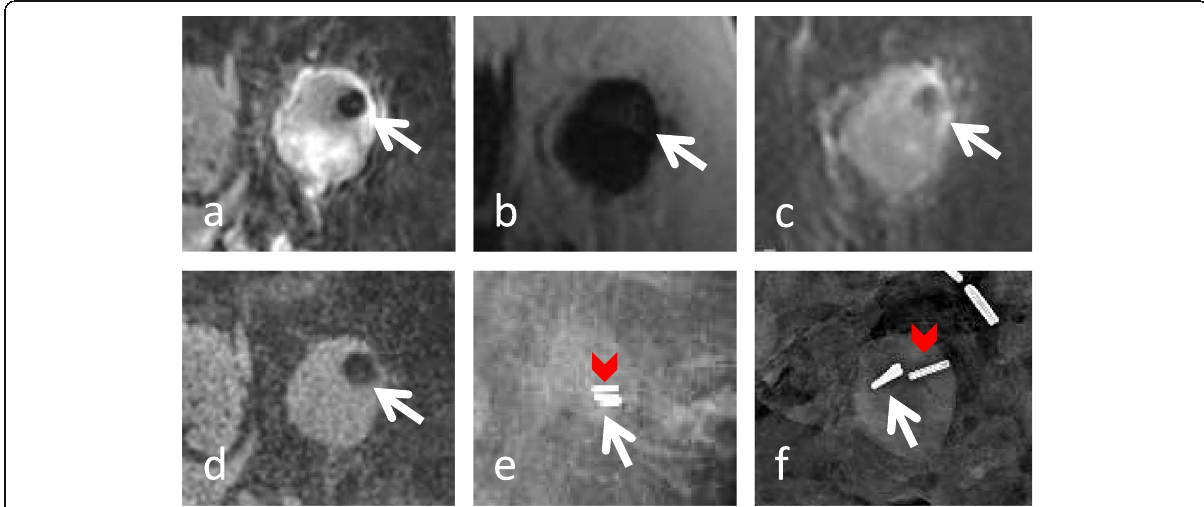
Fig. 1 A 55-year-old female with left breast multifocal invasive ductal carcinoma and biopsy proven metastatic axillary lymphadenopathy. A MammoMark® (Mammotome, Cincinnati, OH) U-shaped marker was placed after biopsy of an abnormally enlarged axillary lymph node. Initial staging magnetic resonance imaging performed 1 week after marker placement demonstrates susceptibility artifact from the marker within an abnormally enlarged lymph node on various sequences. a On the T2-weighted water-only image, the marker is dark and seen with high confidence. b On the T2-weighted fat-only image, the marker is seen with low confidence (arrow). c On the first contrast-enhanced fat- suppressed three-dimensional T1-weighted spoiled gradient-recalled image, the marker is dark (arrow) and seen with high confidence. d On the unenhanced fat-suppressed three-dimensional T1-weighted spoiled gradient-recalled image, the marker is dark (arrow) and seen with high confidence. e Post-seed localization mammogram demonstrates the marker (arrow) adjacent to a radioactive seed (arrowhead/chevron). f Surgical specimen shows marker (arrow) and radioactive seed (arrowhead/chevron) within the metastatic lymph